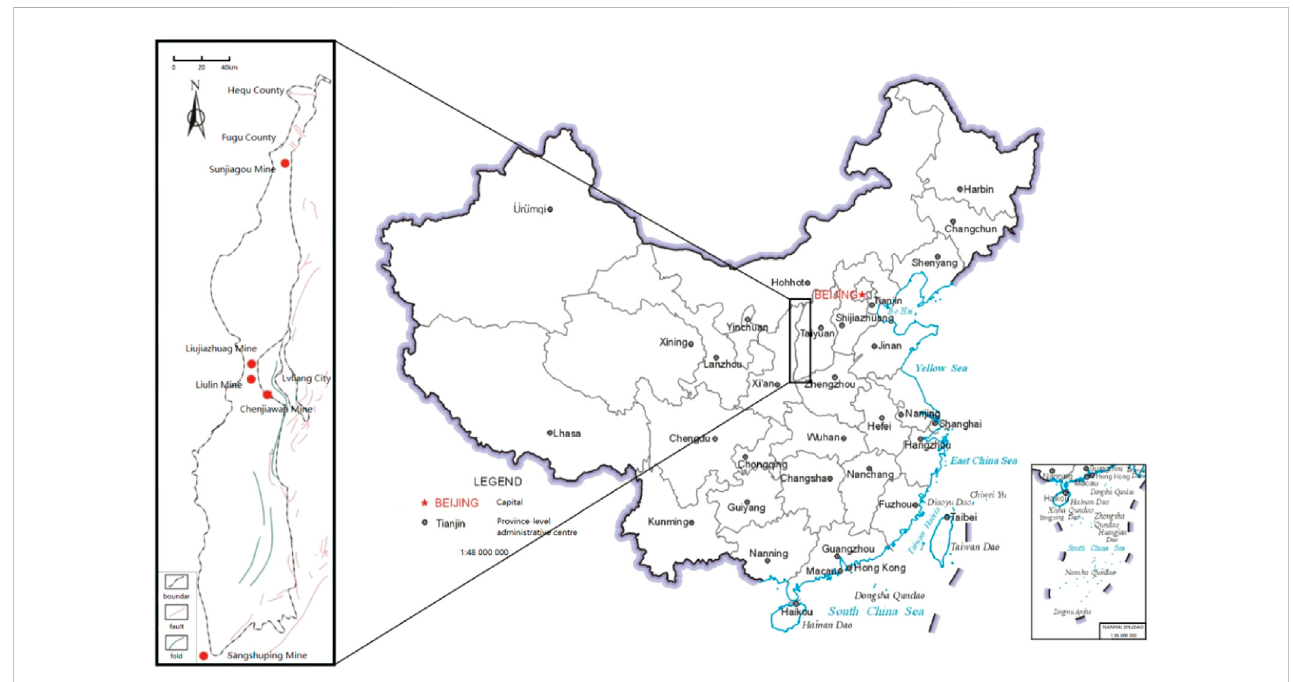
FIGURE 1 Location of coal samples collected.